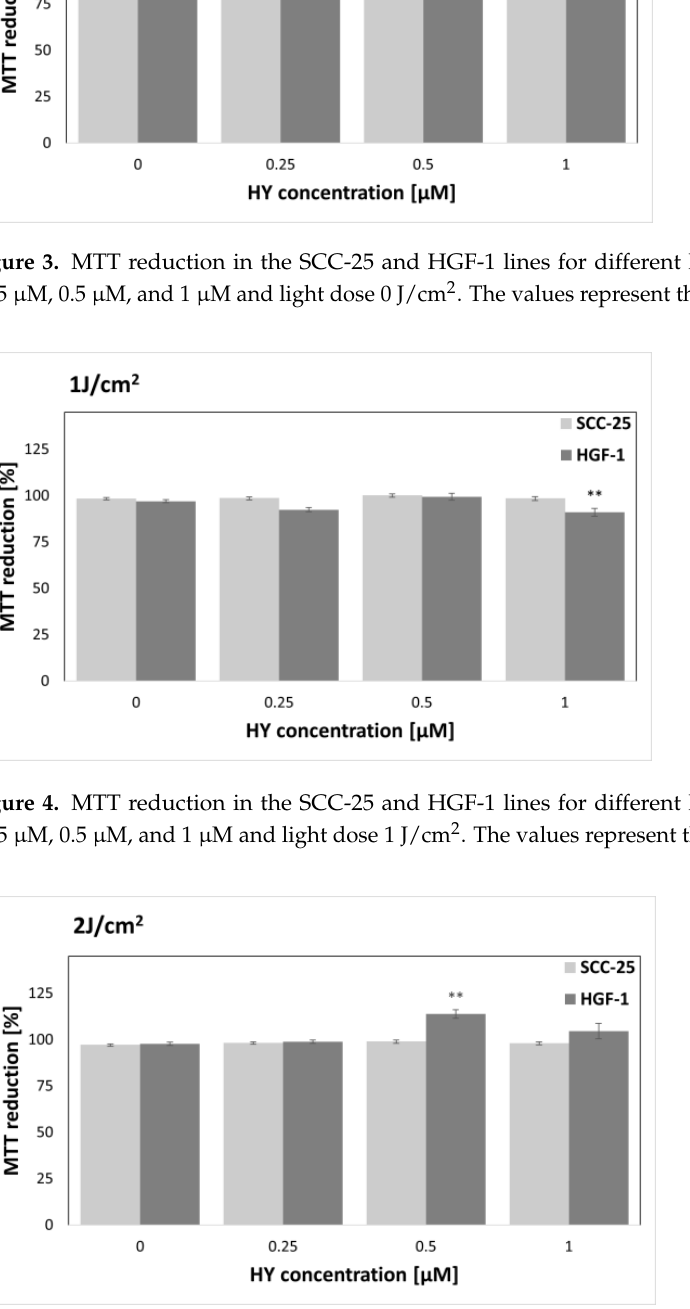
Figure 5. MTT reduction in the SCC-25 and HGF-1 lines for different HY concentrations: 0 µM, 0.25 µM, 0.5 µM, and 1 µM and light dose 2 J/cm 2 . The values represent the means ± SE. ** p < 0.05.